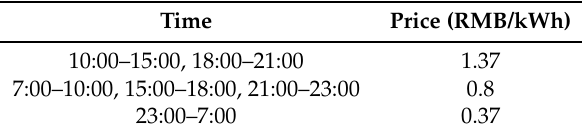
Table 1. Time-of-use price.